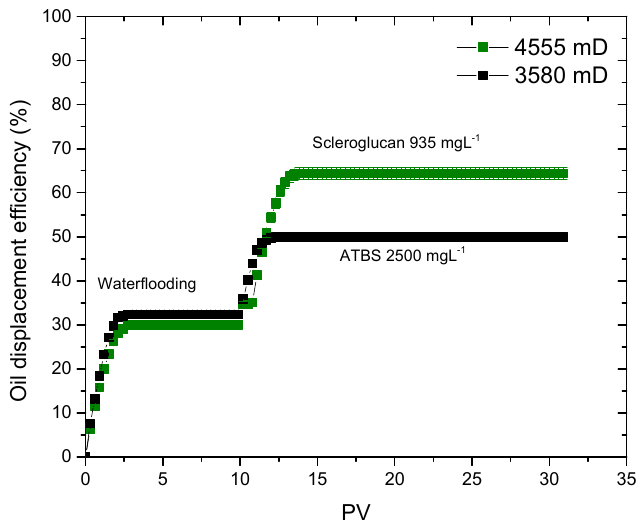
Figure 5. Oil recovery efficiency after waterflooding (3800 mgL − 1 TDS) and biopolymer flooding (SG, 935 mgL − 1 ) in a representative core plug. The porous media is a composite representative formation with porosity (ø) and permeability ( k ) of 19–21% and 3580–4555 mD, respectively. The dimensions of